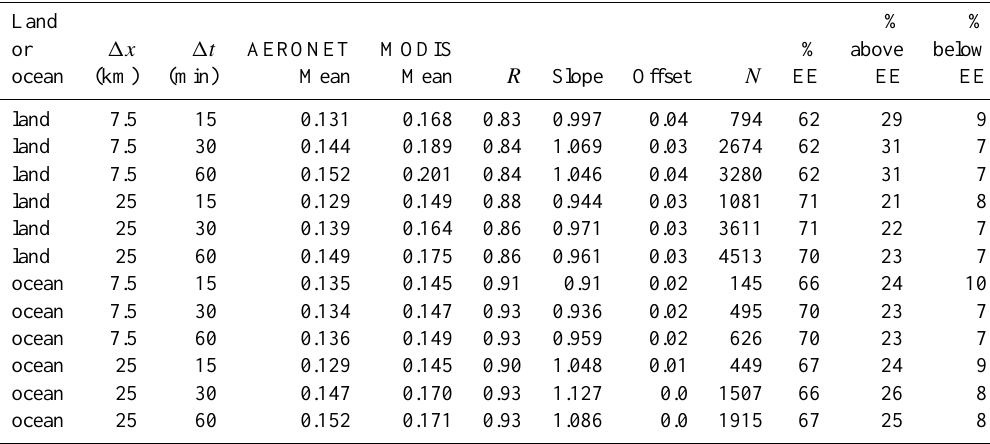
Table 5. Same as Table 4, but using results from a different version of the MODIS aerosol algorithm (Test881) and for a variety of temporal and spatial averaging windows in the collocation between the 3km retrieval and AERONET. Land % % or 1x 1t AERONET MODIS % above below ocean (km) (min) Mean Mean Slope